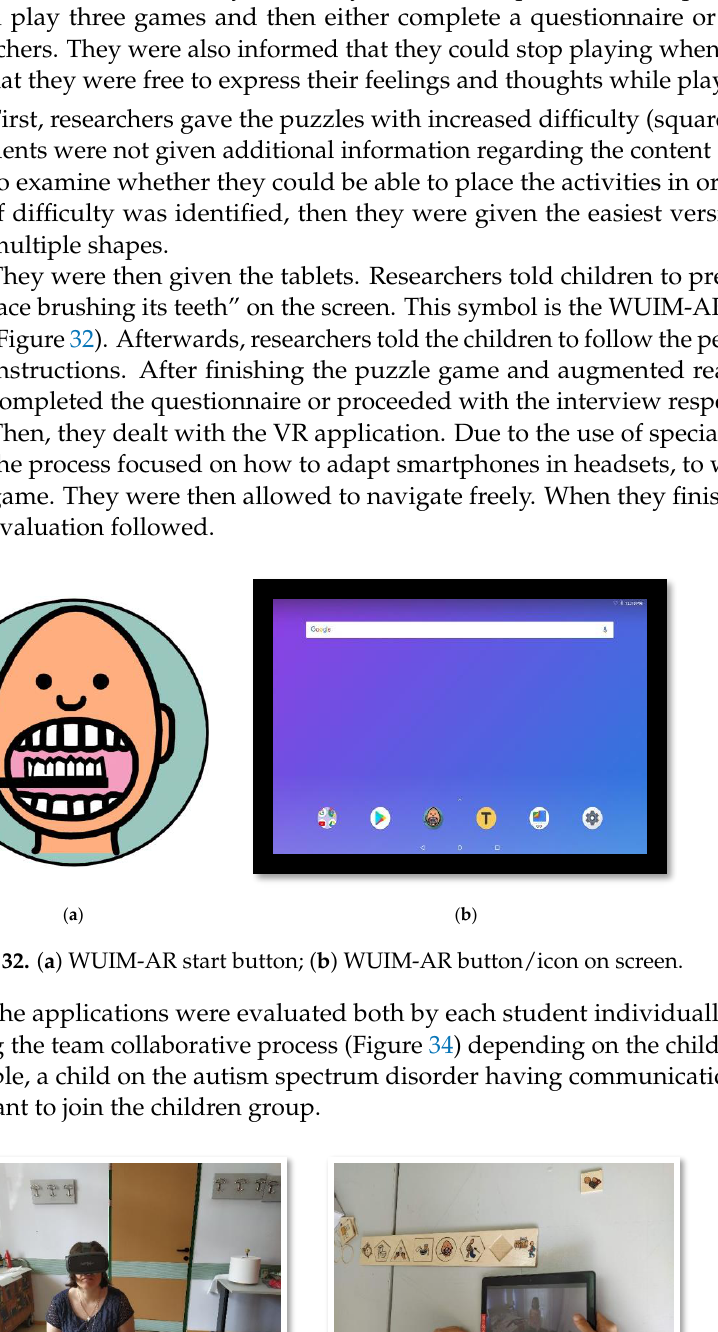
( b ) Figure 34. Team evaluation: ( a ) students with intellectual disability; ( b ) students with cerebral palsy and without intellectual disability. 5. Results Due to the small sample, we did not statistically analyze the data we collected from the questionnaires and structured interviews but we proceeded with trend analysis. We also drew conclusions from our observations and the recordings of the participants ’ think- aloud protocol. In sum, the results of the Likert scale five-point “ strongly disagree ” (1) to “ strongly agree ” (5) trend analysis are presented below (Tables 4 and 5). All participants (students and experts) rated the applications with a score of 4 or 5, that is agree or strongly agree. The comparative correlation of the results points out that children have evaluated more positively than content experts.